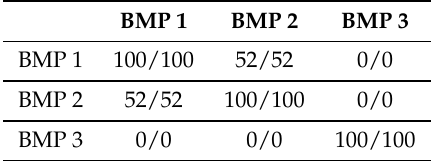
Table 17. Test results for similar BMP images with ssdeep.